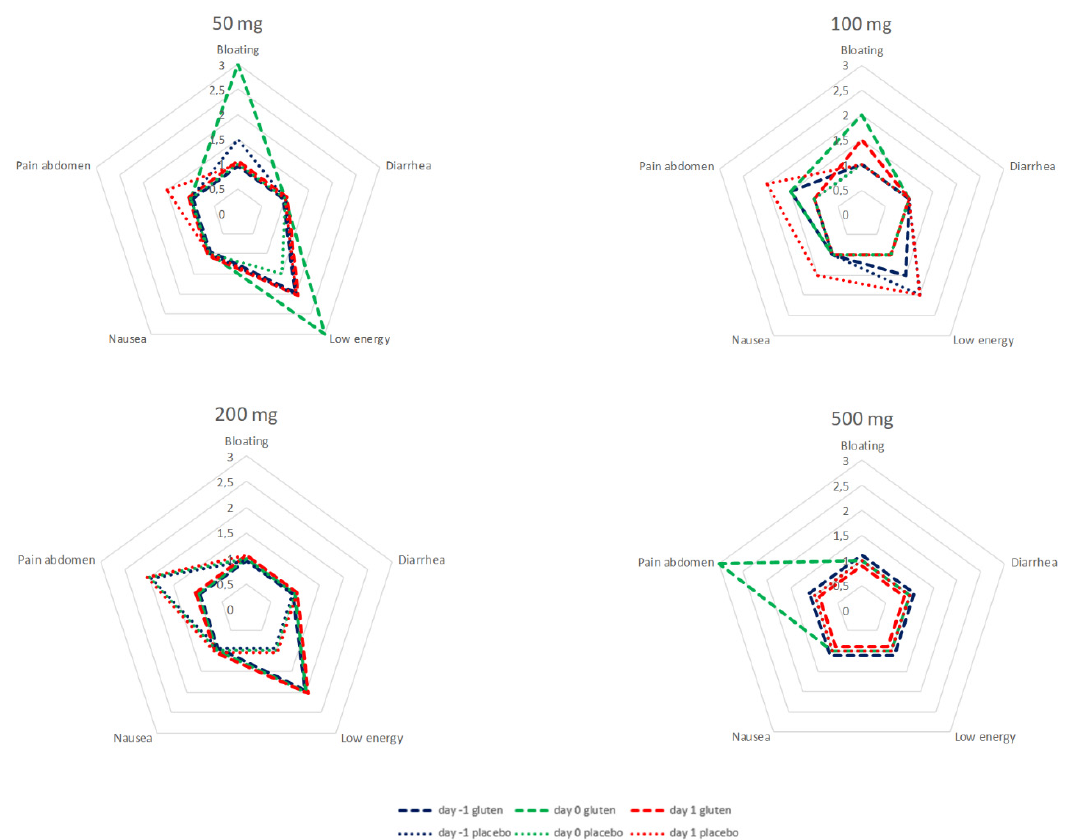
Figure 6. Symptoms from 24 h before until 48 h after ingestion of 50, 100, 200, and 500 mg of gluten and placebo. Only patients with positive GIP after gluten and patients with negative GIP after placebo were included in the analysis. x -axis: the median answer on the 5-point Likert-scale (ranging from none of the time (0 points), a little of the time (1 point), some of the time (2 points), most of the time (3 points) and all of the time (4 points)) per cycle.